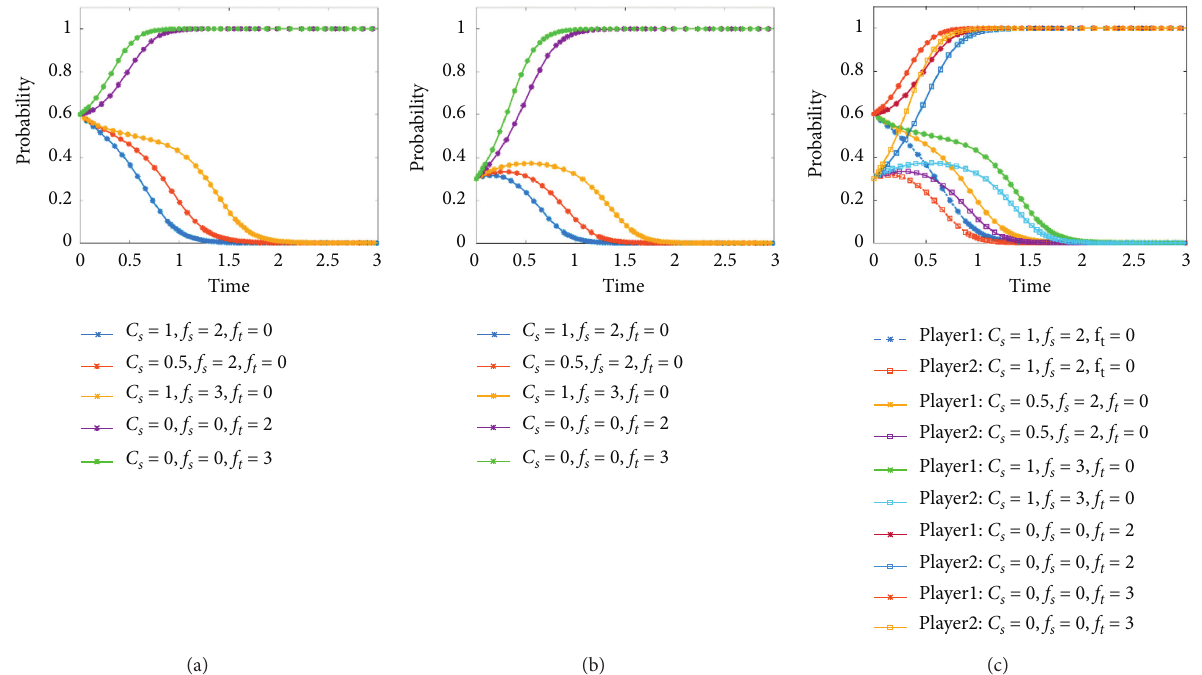
Figure 5: The dynamical evolutionary processes of the probability of knowledge sharing for four punishment types: no punishment ( y second-party punishment ( y ), third-party punishment ( y 2 player2; and (c) the results for both players.